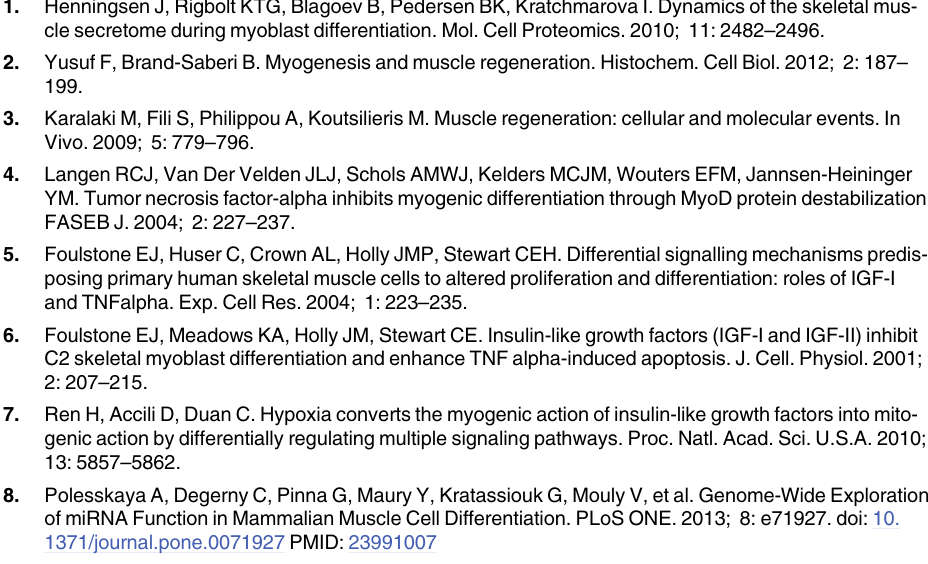
S7 Table. Enrichment of collectively targeted genes in GO and disease terms. We showed results for genes targeted by at least three miRNAs and refer to these as collectively targeted genes. Collectively targeted genes were associated with (A) GO terms ‘ biological processes ’ . (B) The top 20 enriched MeSH disease terms of collectively targeted genes. S8 Table. MiRNA-mRNA relations of high interest. Table of miRNAs showing the selected miRNA-mRNA relations of high interest based on the selection workflow depicted in Fig 1. Column “ predicted to be targeted by . . . . ” is based on data of this study whereas column “ previ- ous evidence . . . . ” is based on literature